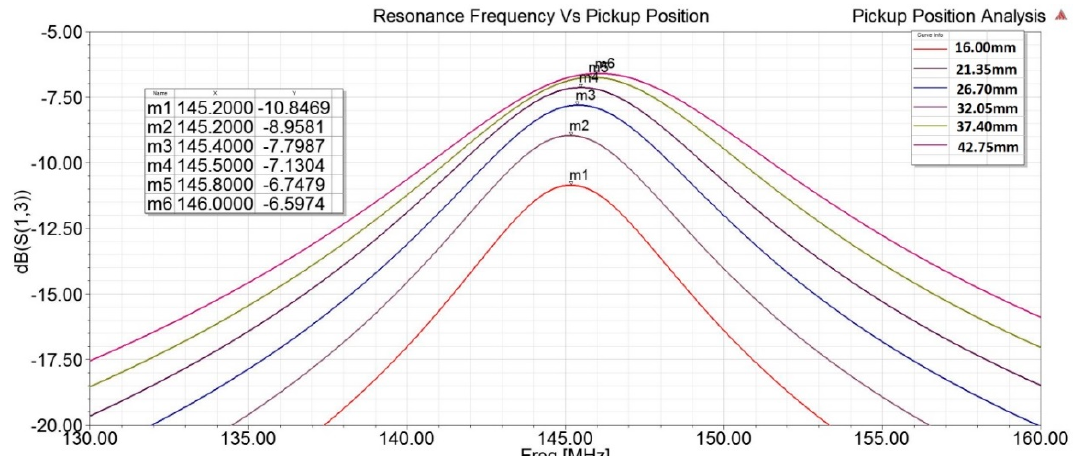
Figure 6. Simulation results for the resonance frequency as a function of the pickup position. Markers represent the resonance frequency and signal coupling to beam entry port for different pickup positions.